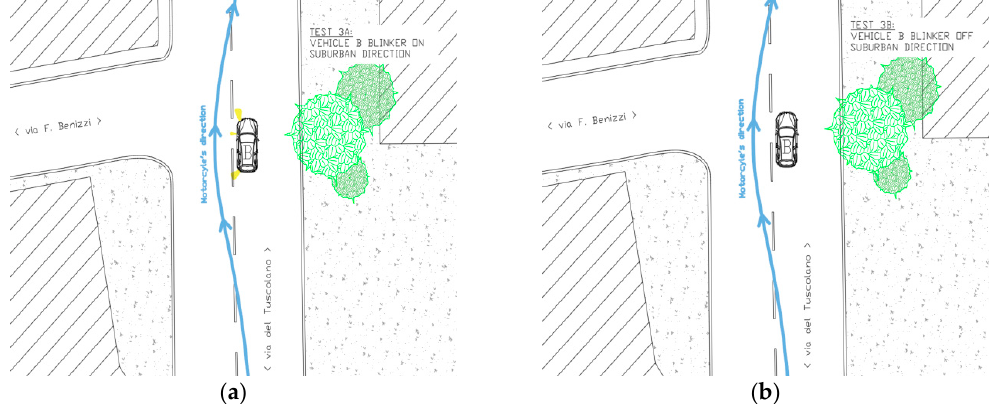
Figure 5. Simulation 3( a ) overtaking, and 3( b ) overtaking, schemes.